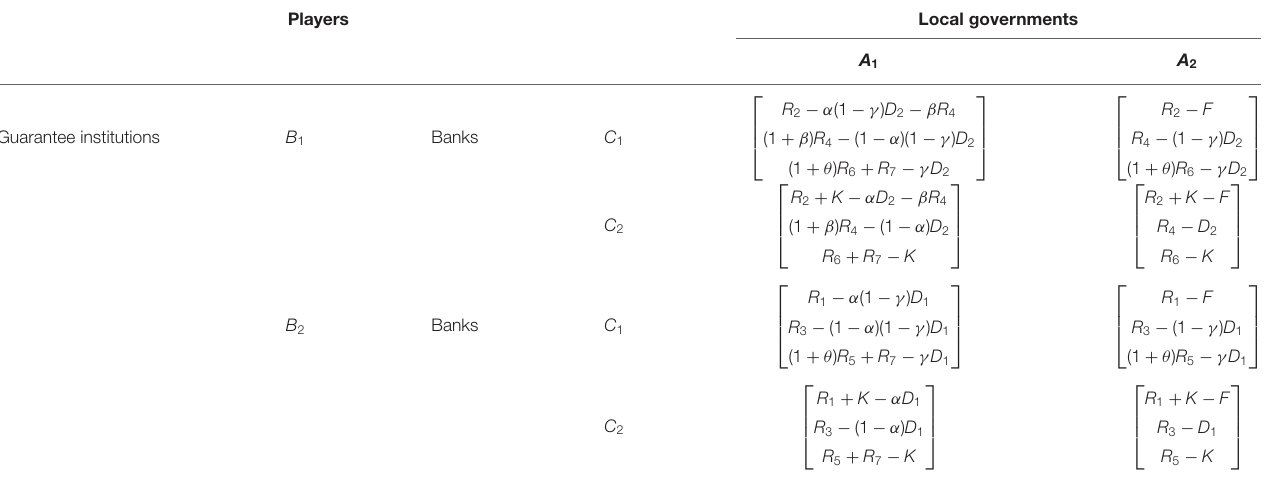
TABLE 1 | The payment matrix of the evolutionary game model.